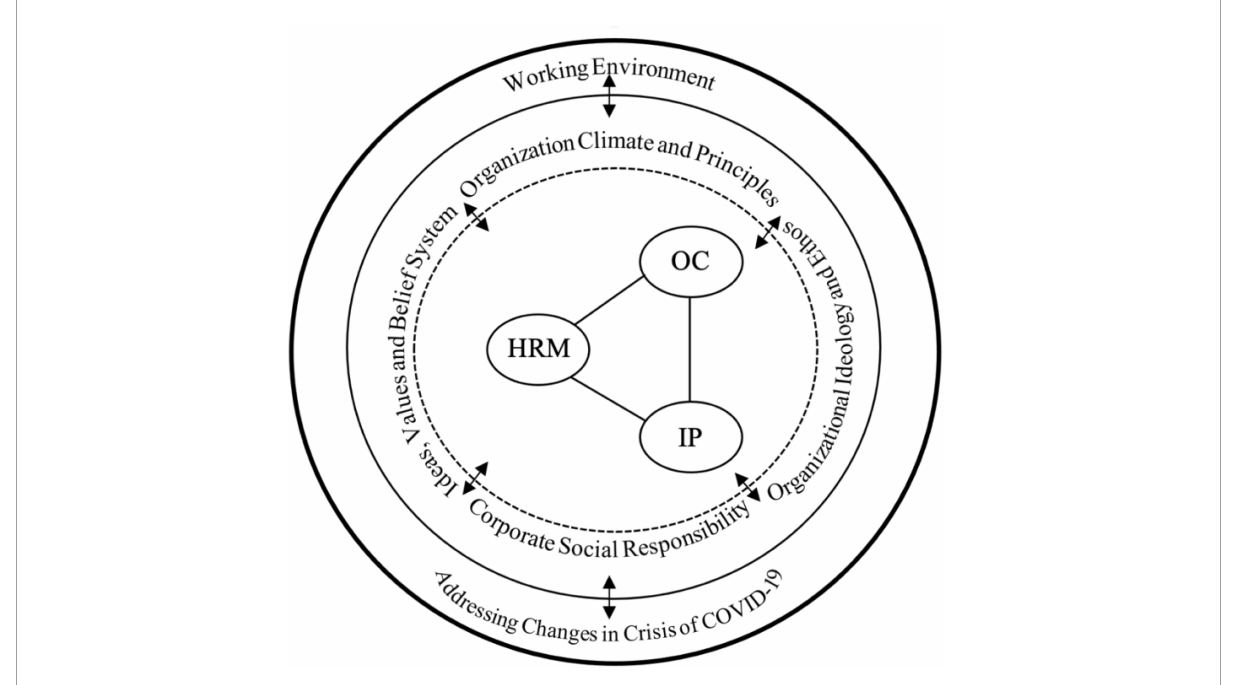
FIGURE1 Working environment and epidemic crisis.